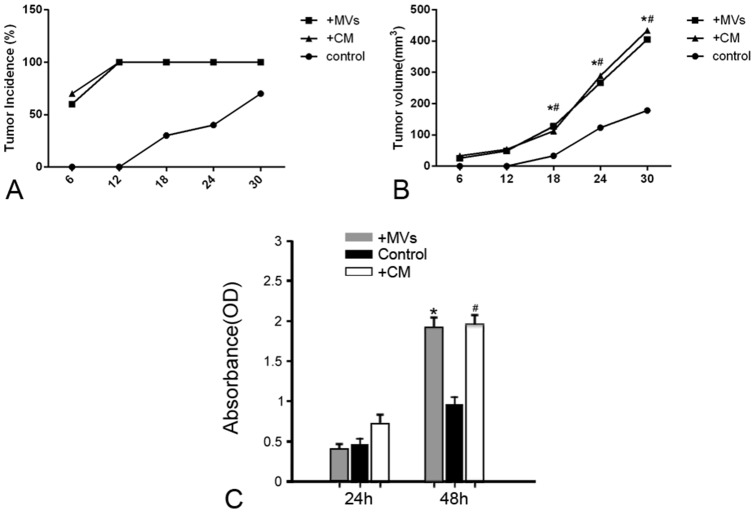
The medium conditioned by hWJ-MSCs have a similar pro-tumor effect as MVs both in vivo and in vitro.
(A) Tumor incidence. There was a higher tumor incidence in nude mice treated with CM or MVs as compared with control; (B) Tumor volume. In contrast to control, CM or MVs led to the development of a bigger tumor in nude mice. *P<0.05, MVs vs. control; #
P<0.05, CM vs. control; (C) CCK-8 Assay. After 48 h incubation with 786-0 cells, CM or MVs greatly promoted tumor cell growth. *P<0.01, MVs vs. control; #
P<0.01, CM vs. control.